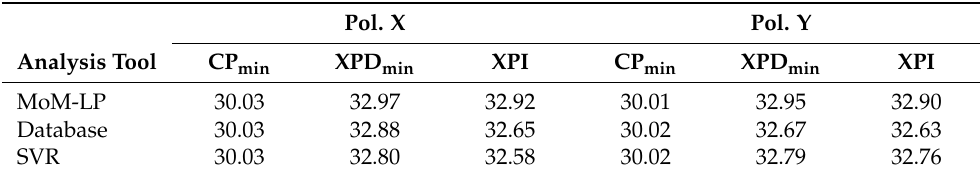
Table 3. Figures of merit of a European coverage pattern when the design is carried out using the database and simulated with different tools. CP min is in dBi and XPD min and XPI are in dB. Pol. X Pol. Y